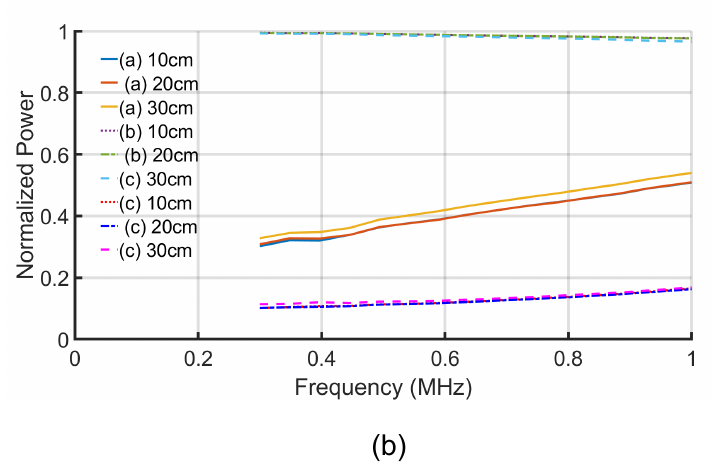
Figure 6. The efficiency and normalized power versus the separation distance and the frequency: